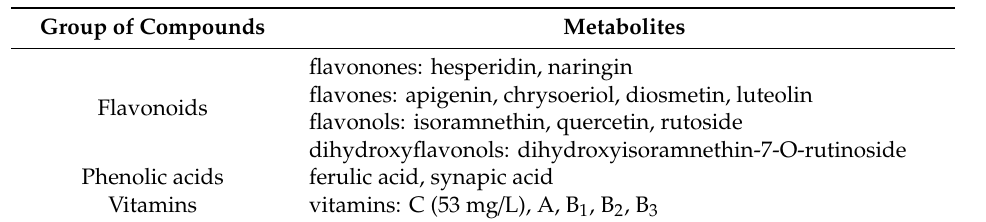
Table 4. Composition of C. limon